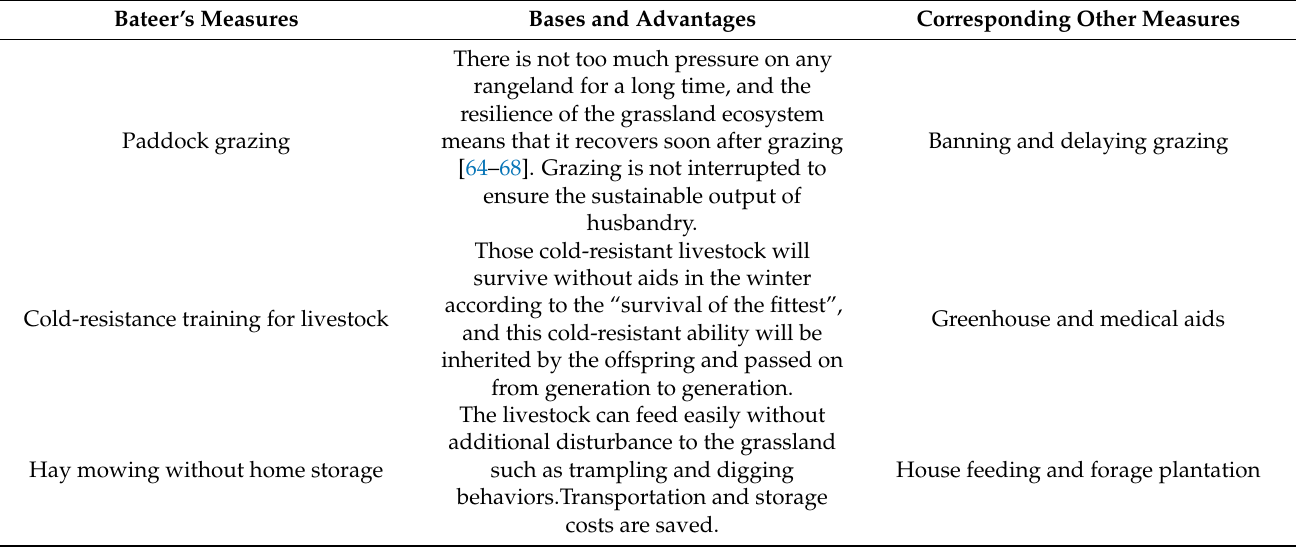
Table 1. The bases and advantages of Bateer’s measures.